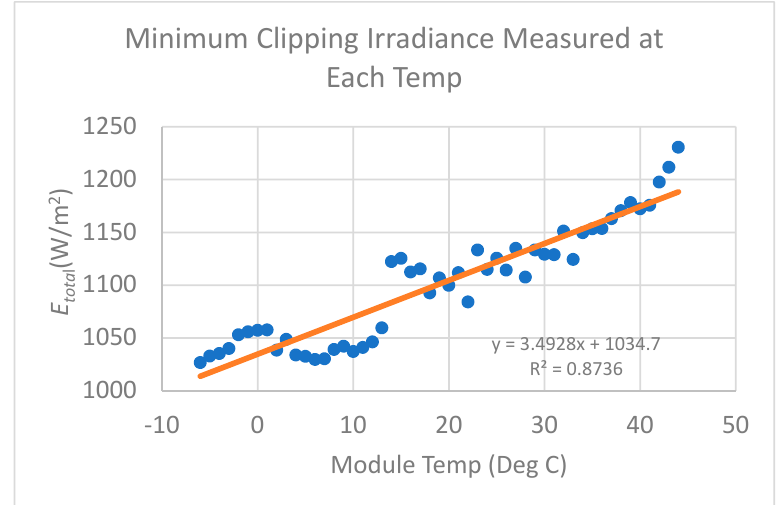
Figure 9. The relationship between the minimum total irradiance value where clipping occurred at each temperature is shown along with a line of best fit. Values that fall above the line would be clipped at a 290 W output by the inverters.